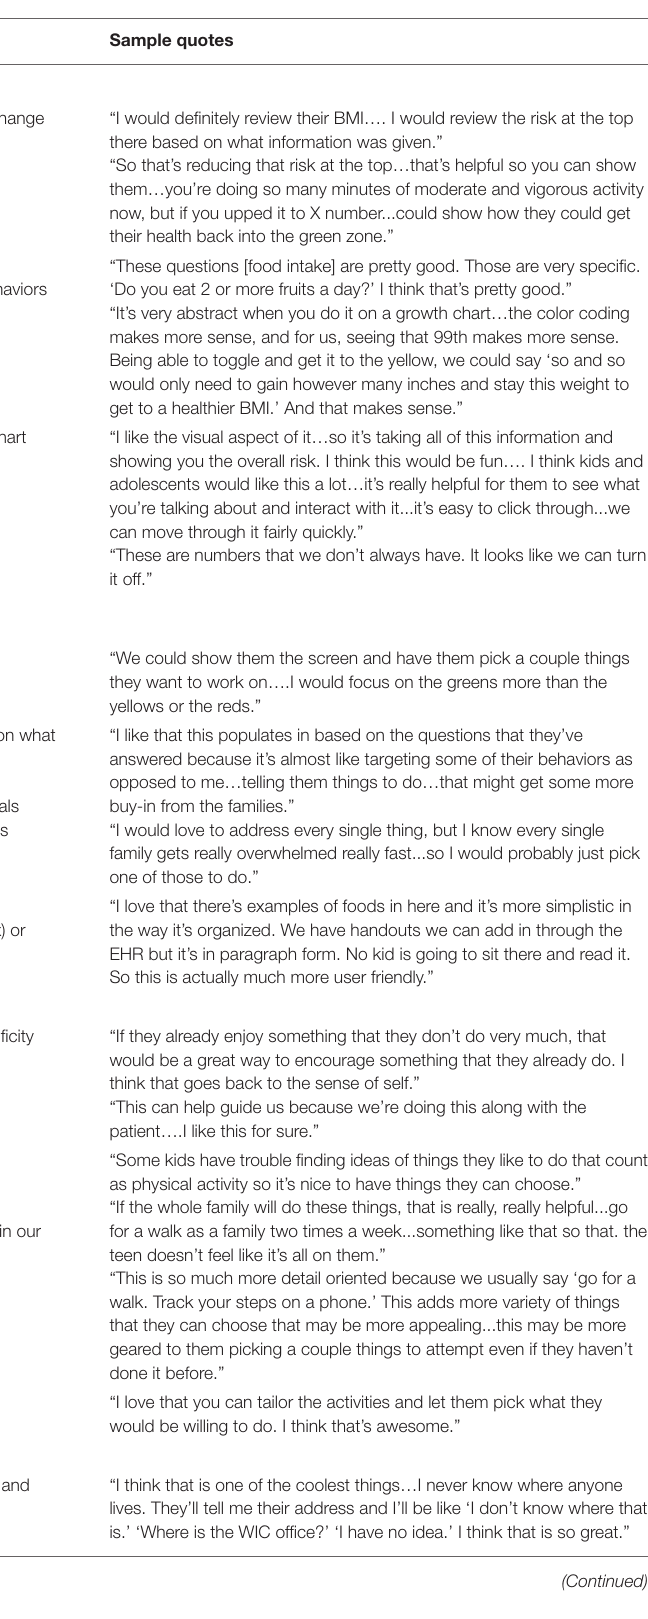
TABLE 3 | Summary of user testing